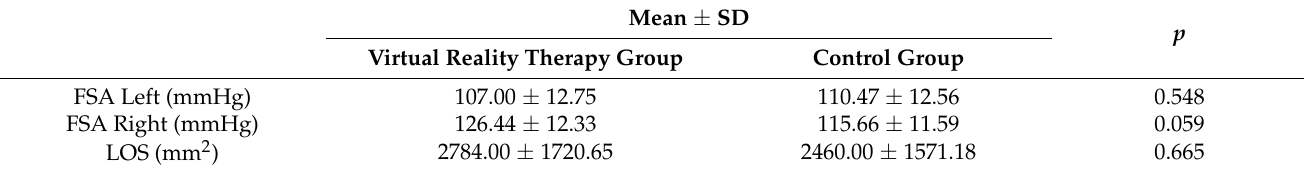
Table 2. Comparison of the baseline in the two groups.